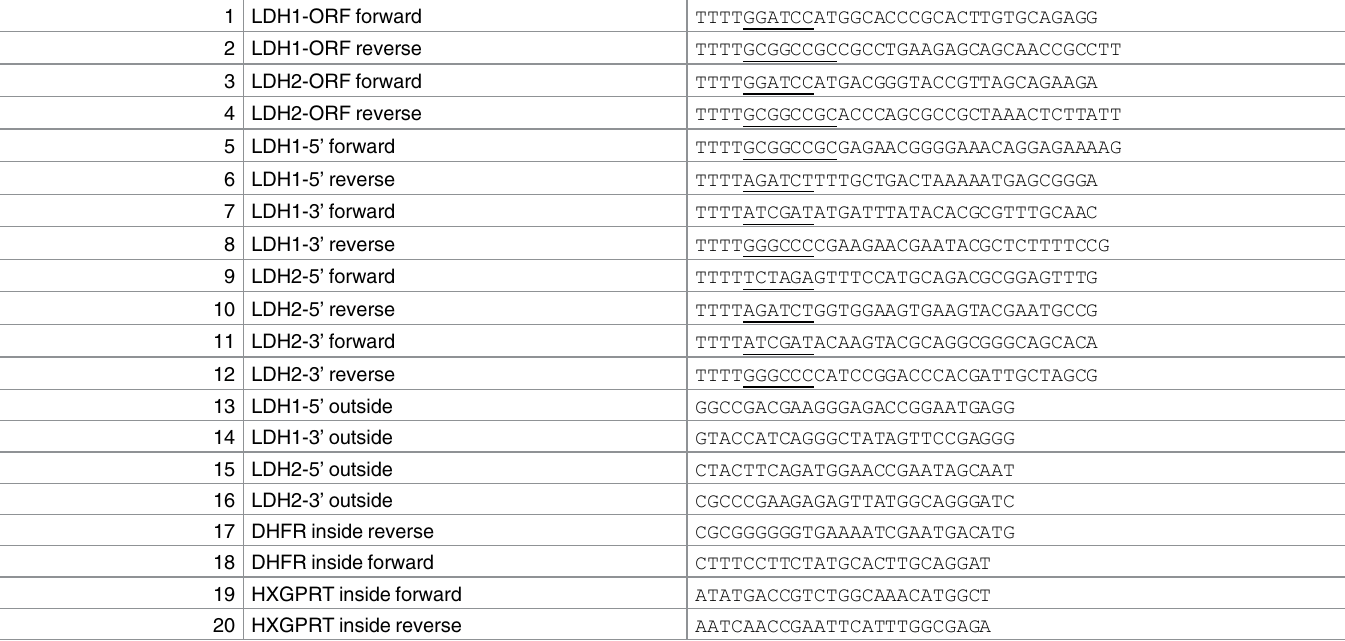
Table 1. Oligonucleotides used in this study. The sequencescorresponding to the recognitionsites of restriction endonucleases are underlined. 1 LDH1-ORF